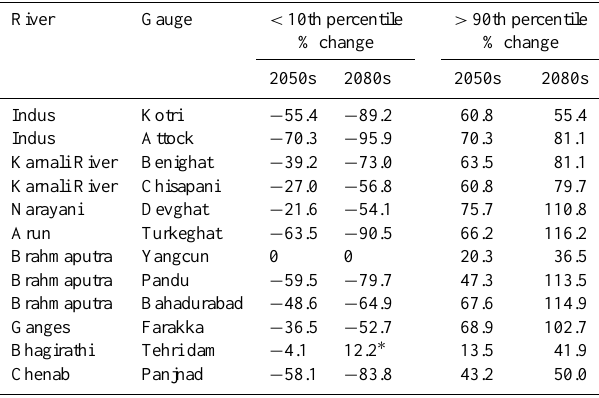
Table 2. Table showing the average percentage change for the two models in the number of times the modelled river flow is less than the 10th percentile and greater than the 90th percentile of the 1970– 2000 period for the 2050s and 2080s future